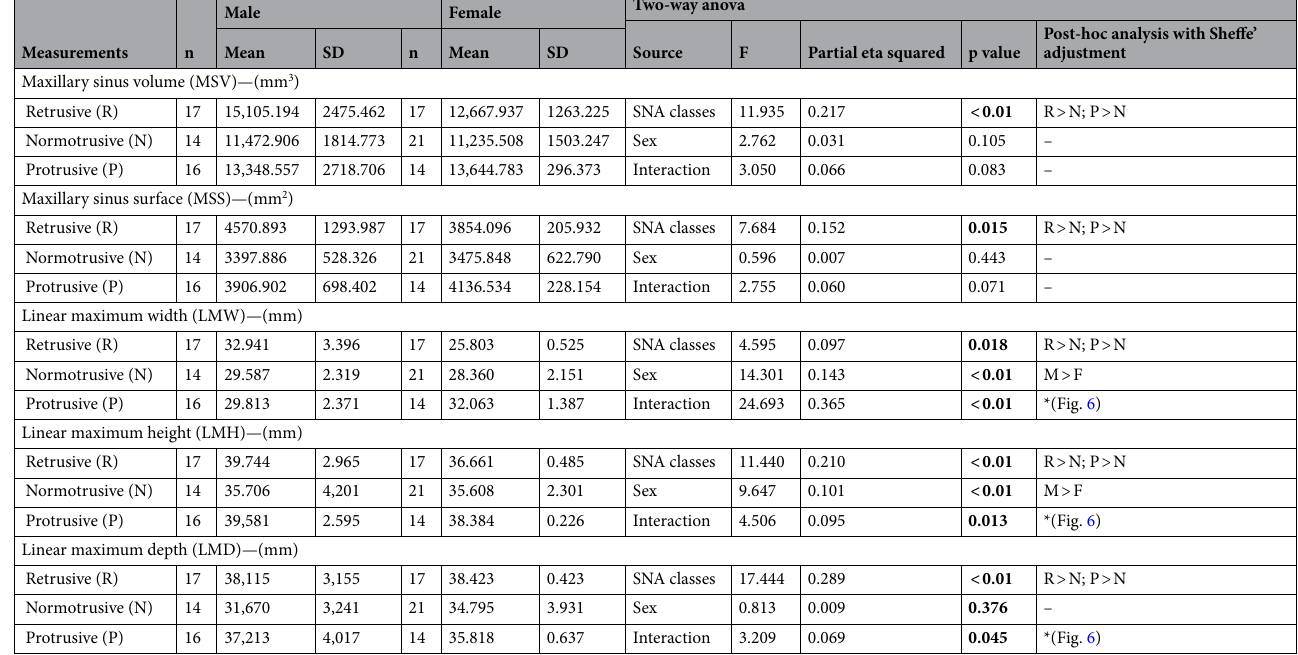
Table 4. Two-way ANOVA with SNA and gender as categorical independent variables and MS measurements. Significant values are in bold. A p value < 0.05 was considered statistically significant.